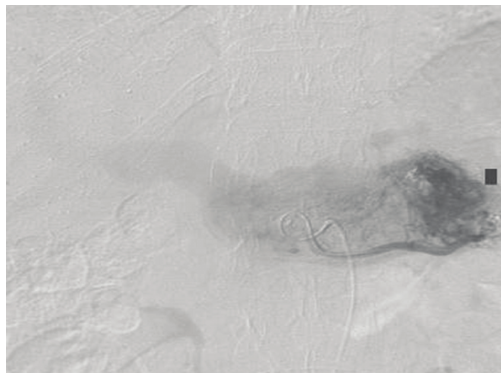
Figure 2: Superior mesenteric angiogram shows prominent vascu- larity in the pancreatic mass during the arterial